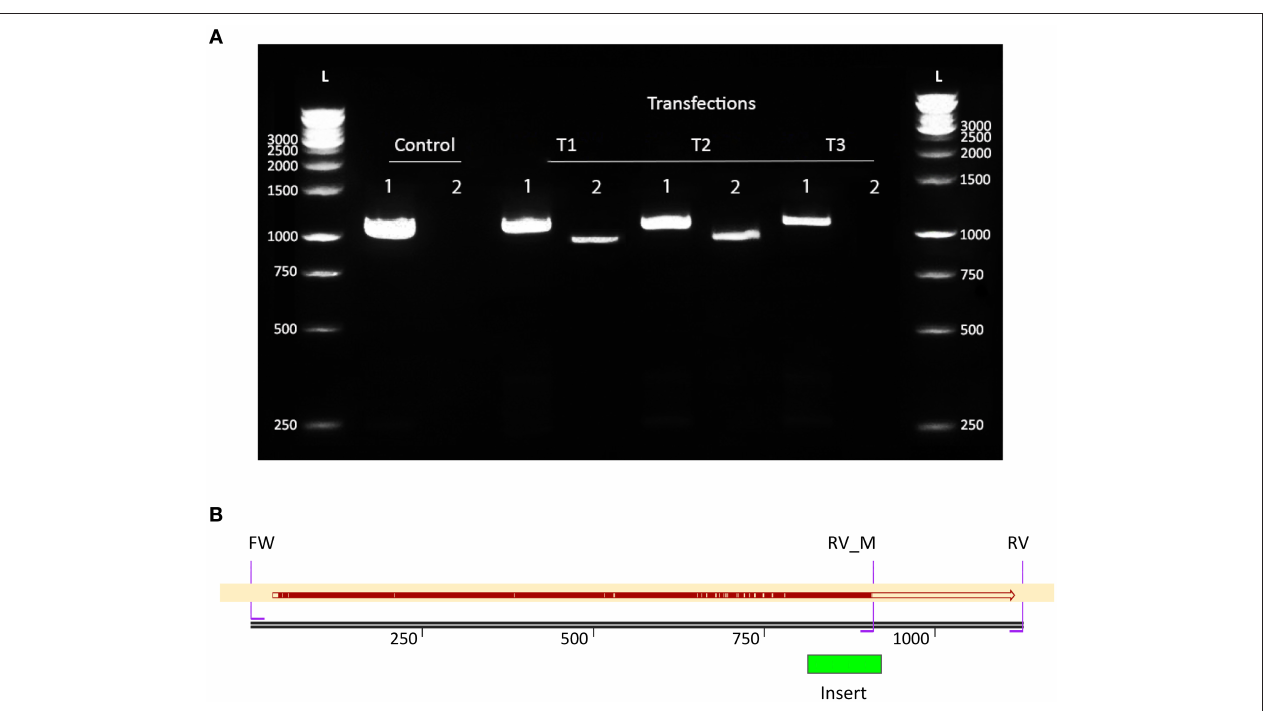
FIGURE 4 | PCR and sequencing results confirm that the scrambled DNA sequence was inserted in populations of transfected cells. (A) Results of 2 PCR reactions amplifying part of the OAS1Ab gene in DNA extracted from 3 transfected G. barretti cell populations (T1, 2 and 3). Both reactions used the same FW primer. PCR 1 used the wildtype RV primer and should always amplify a 1,025 bp (W) or 1,127 bp (M) product. PCR 2 contained the mutant RV (RV_M) primer and only yields a 910 bp product (M) if the gene was successfully edited. The control (C) contained DNA extracted from cells that were treated the same as T1–3, except that no gRNA was provided in the transfection. T1 and T2 both yielded the M product, indicating the 108 bp scrambled DNA sequence was inserted at the target site in some cells. (B) Alignment of the sequencing results of the 910 bp mutant product with the sequence expected if the OAS1Ab gene was successfully edited. Red indicates matching sequences, while yellow indicates gaps. Since the sequenced PCR product was obtained using PCR 2, the sequence between RV_M and RV was not present in the sequence read.